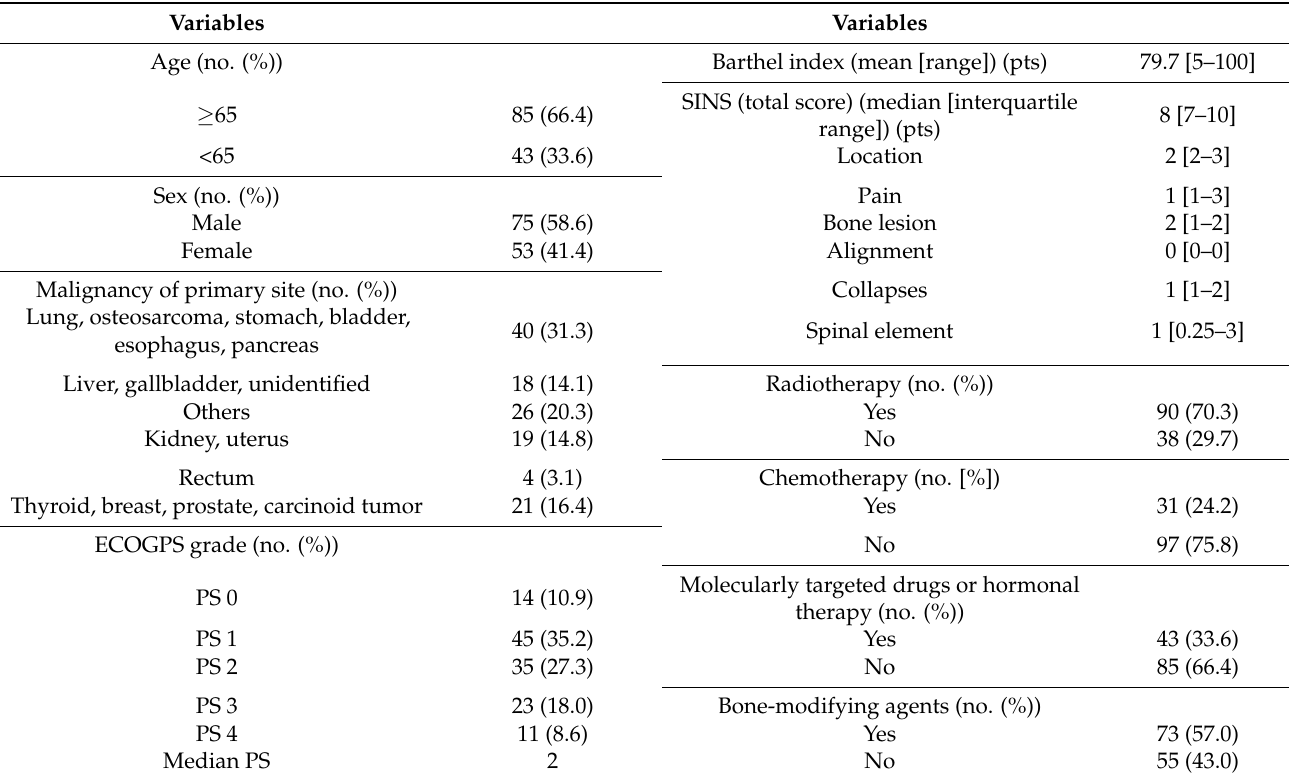
Table 1. Demographic and clinical factors at study enrollment.